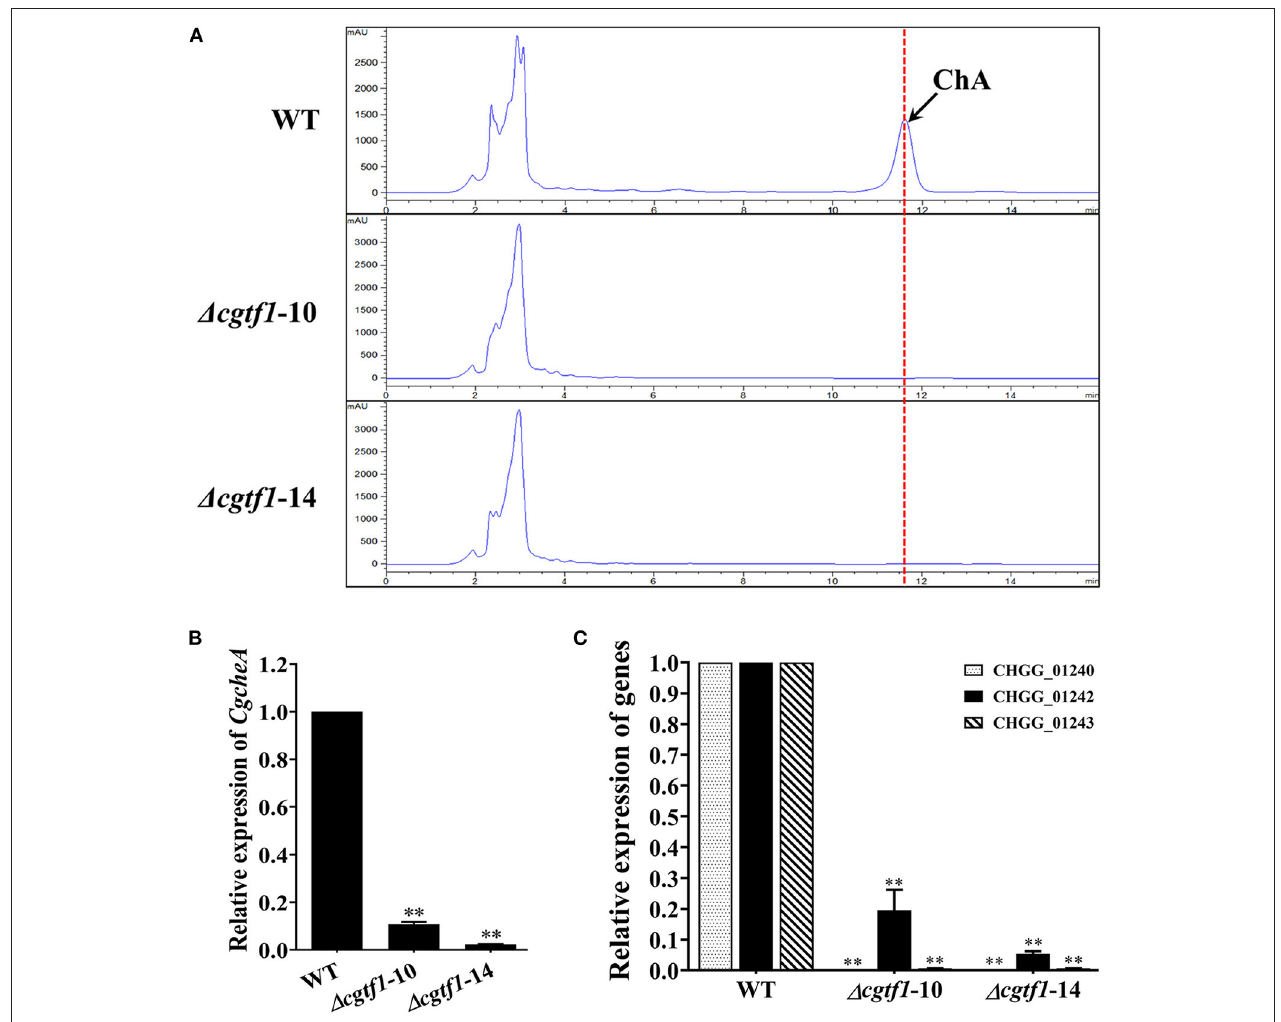
FIGURE 3 | CgTF1 deletion resulted in incapability of ChA biosynthesis. (A) The CgTF1 null mutants lost the ability to produce ChA. HPLC analysis on the production of ChA in the wild-type (WT), ∆ cgtf1 -10 and ∆ cgtf1 -14. The dotted line indicates the peak of ChA. (B) CgTF1 deletion suppressed transcription of CgcheA . (C) CgTF1 deletion suppressed transcription of redox enzyme encoding genes in ChA biosynthetic gene cluster. Transcript levels of the CHGG_01240, CHGG_01242-1, CHGG_01243 were detected by qRT-PCR in the wild-type, ∆ cgtf1 -10 and ∆ cgtf1 -14 mutants. All experiments were performed in triplicate. Transcripts of all indicated genes was normalized against ACTIN . There is significantly difference between the WT and CgTF1 null mutants as indicated by two asterisks ( p -value < 0.01, with T -test